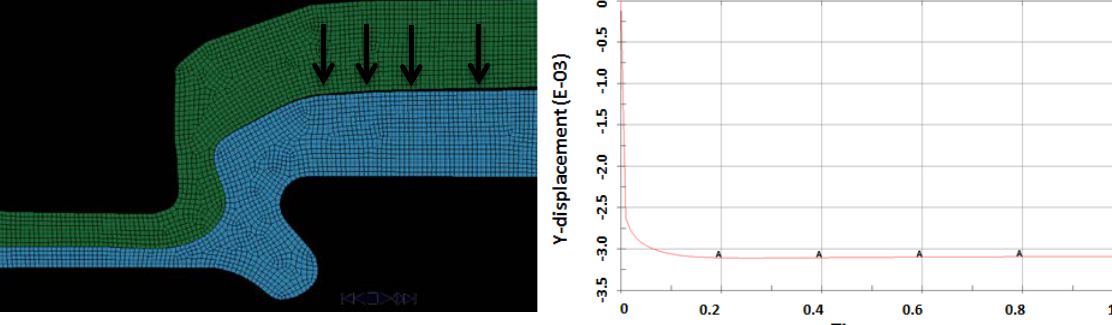
Figure 6: Springback between the two joints before the release of the stress (springback analysis)